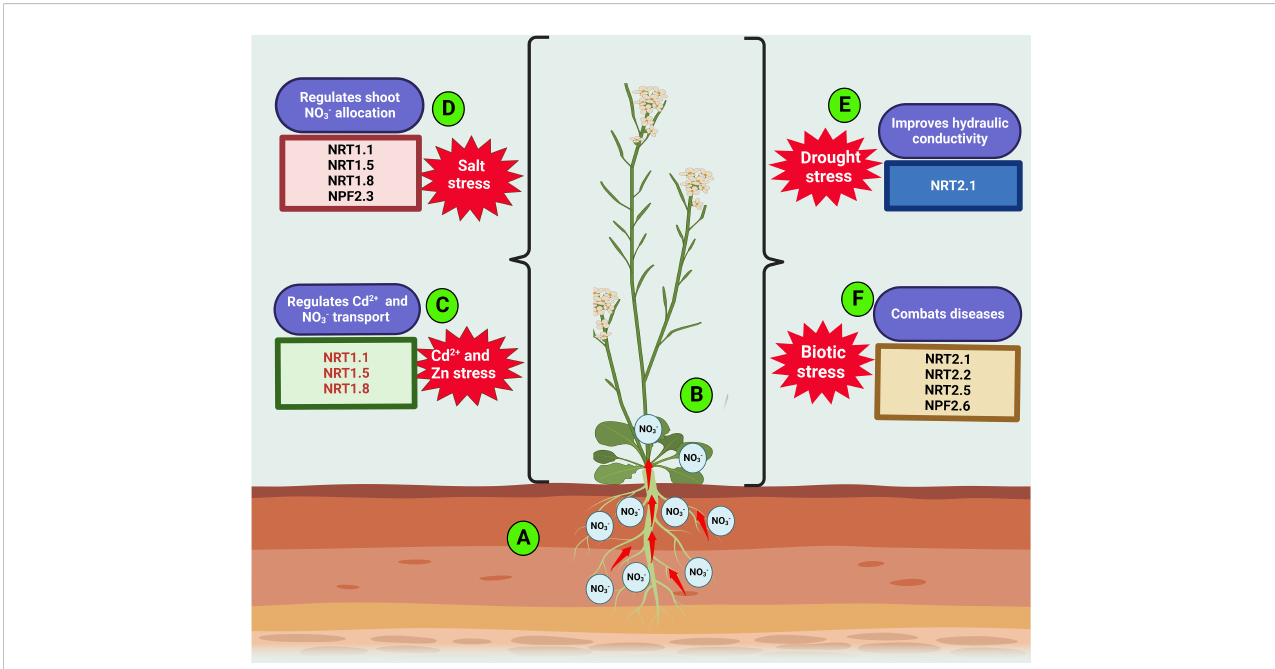
FIGURE 2 Roles of nitrate transporters in plant response to adverse environmental conditions. Environmental cues including heavy metals (Cd 2+ and Zn), salinity, drought, and pathogenic stress engender reduction in plant growth and NUE. The resulting stressed plants accumulate more NO 3 (cid:1) at the root (A) while retaining less in the shoot (B) . Under Cd 2+ or Zn stress, nitrate transporters, NRT1.1 , NRT1.5 and NRT1.8 concurrently regulates Cd 2+ or Zn uptake and NO 3 (cid:1) allocation to the root (C) . The transporters involved in root-to-shoot allocation of NO 3 (cid:1) under salinity include NPF2.3 , NRT1.1 , NRT1.5 , and NRT1.8 (D) . NRT2.1 promotes plants ’ tolerance to drought stress (E) . In addition to NRT2.1 , NRT2.2 , NRT2.5 and NRT2.6 are involved in biotic stress regulation (F)